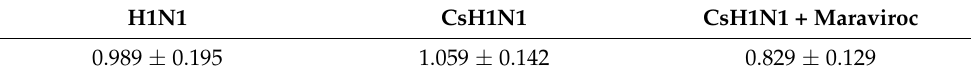
Table 1. The anti-inflammatory effect of Maraviroc does not correlate with viral titer alterations. H1N1